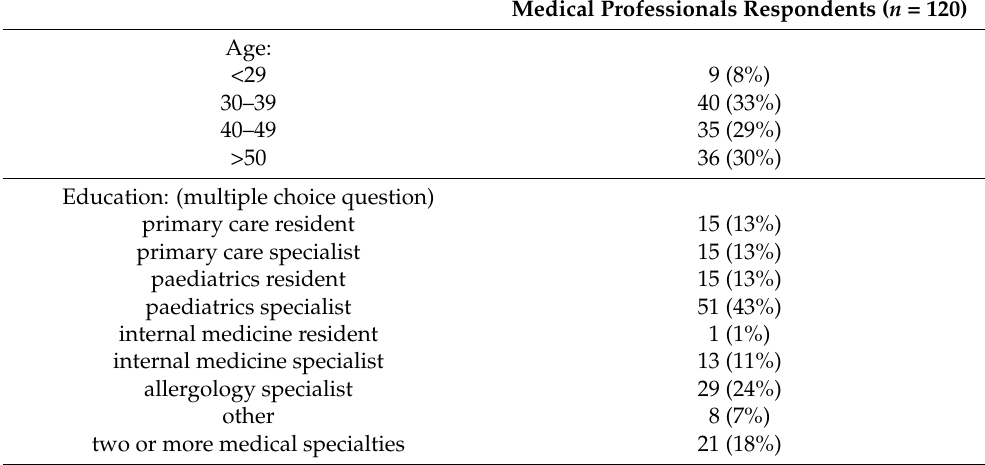
Table 4. Age and professional education of responding